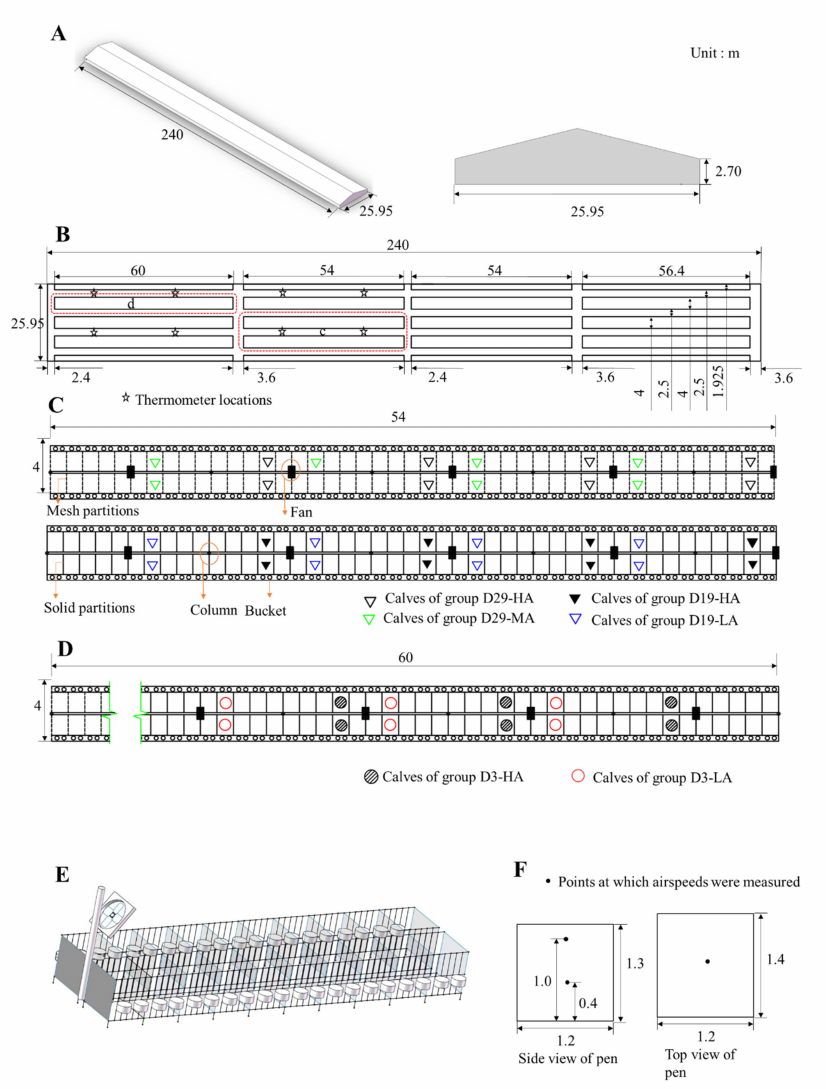
Figure 1. A schematic of the experimental calf house. ( A ) Calf house; ( B ) plan of the experimental house; ( C ) detailed plan of pens for 29 ( ± 3)-day-old and 19 ( ± 3)-day-old calves; ( D ) detailed plan of pens for 3-day-old calves; ( E ) detailed profile of calf pens; and ( F ) airflow speed measurement points in tested